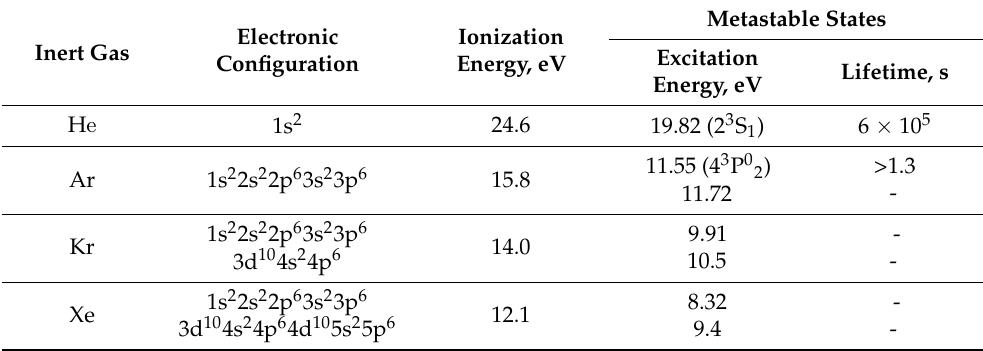
Figure 2. Emission spectra of LIDB plasma in: ( a ) Ar; ( b ) He at 2 atm; ( c ) Kr; ( d ) Xe. Table 2. Electronic configuration, ionization potentials, and characteristics of metastable states of Ar, He, Kr, and Xe [28].